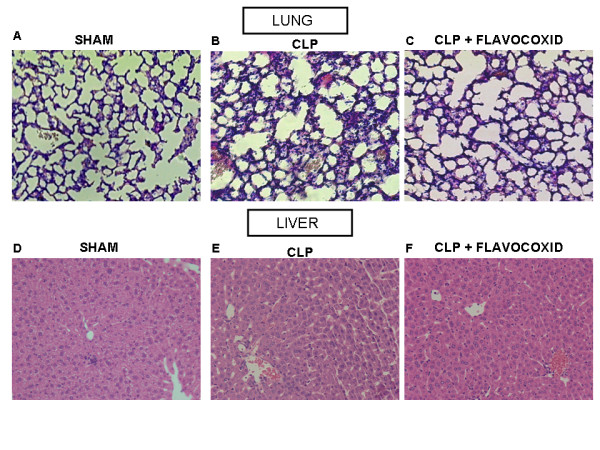
Histology of treated and untreated mice. (a) Normal histology of lung obtained from sham mice. (b) Representative cecal ligation and puncture (CLP)-induced lung damage. (c) Representative lung of CLP mice treated with flavocoxid (20 mg/kg, ip, administered 1 hour after surgery, repeated every 12 hours). (d) Normal histology of liver obtained from sham mice. (e) Representative CLP-induced liver damage. (f) Representative liver of CLP mice treated with flavocoxid (20 mg/kg, ip, administered 1 hour after surgery, repeated every 12 hours). Sham and CLP mice were killed 18 hours after surgery. Histopathology was performed on lung and liver. Original magnification, ×20.